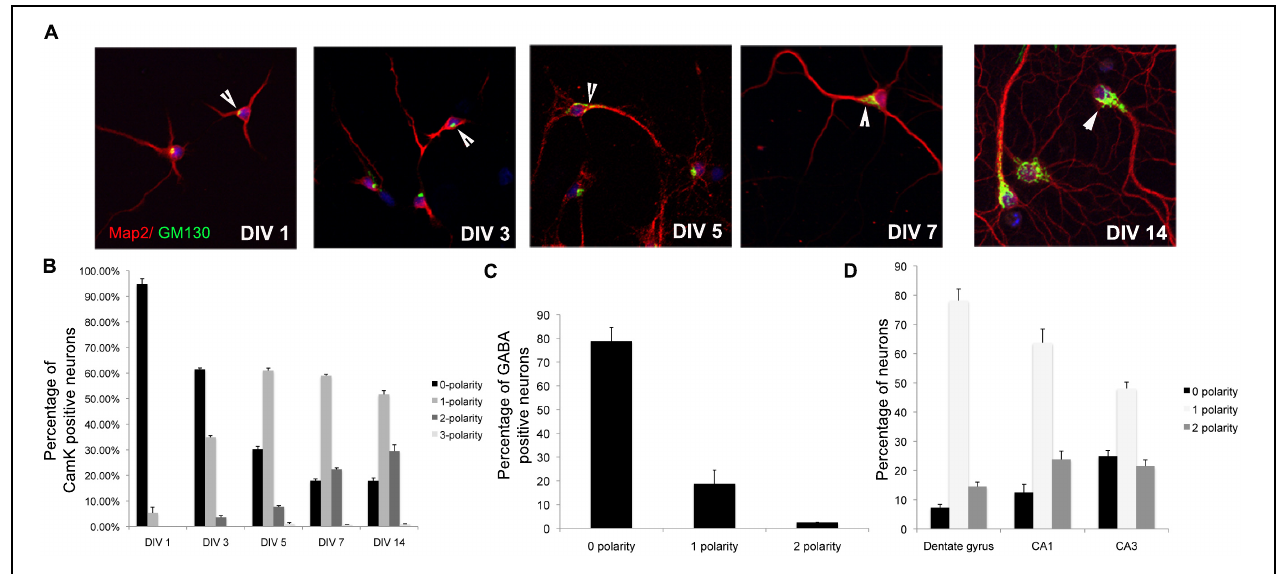
FIGURE 1 | Temporal stabilization of Golgi polarity relative to dendrite polarity. (A) Representative images of primary neurons in culture immunostained with antibodies to GM130 and MAP2 at days in vitro indicated. Arrowheads indicate Golgi polarization. (B) Percentage of α CamK2